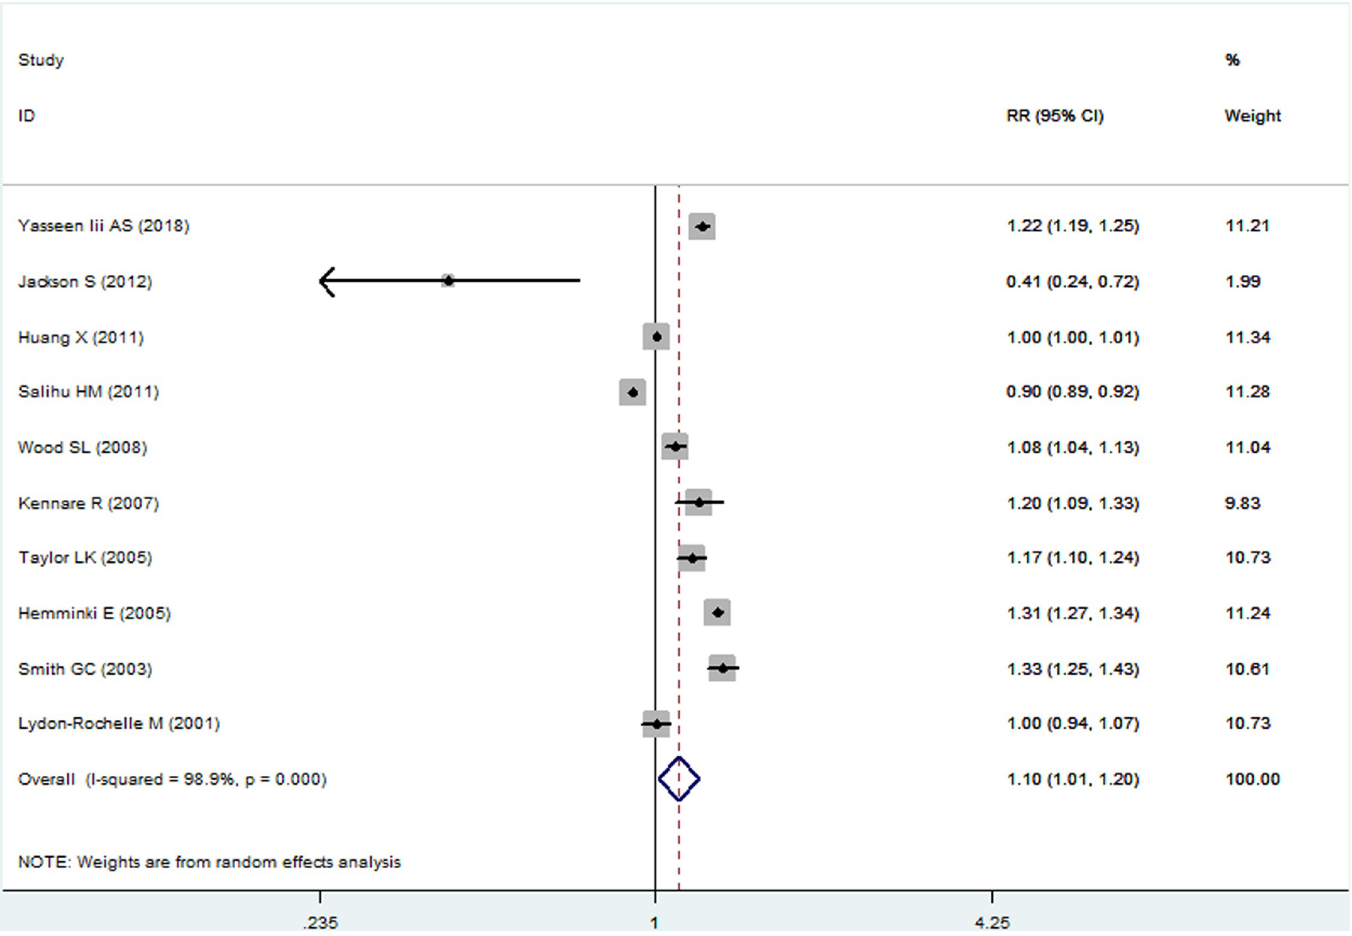
Fig 2. Pooled risk estimates of mode of delivery for preterm birth in subsequent births (cesarean section vs. vaginal delivery).